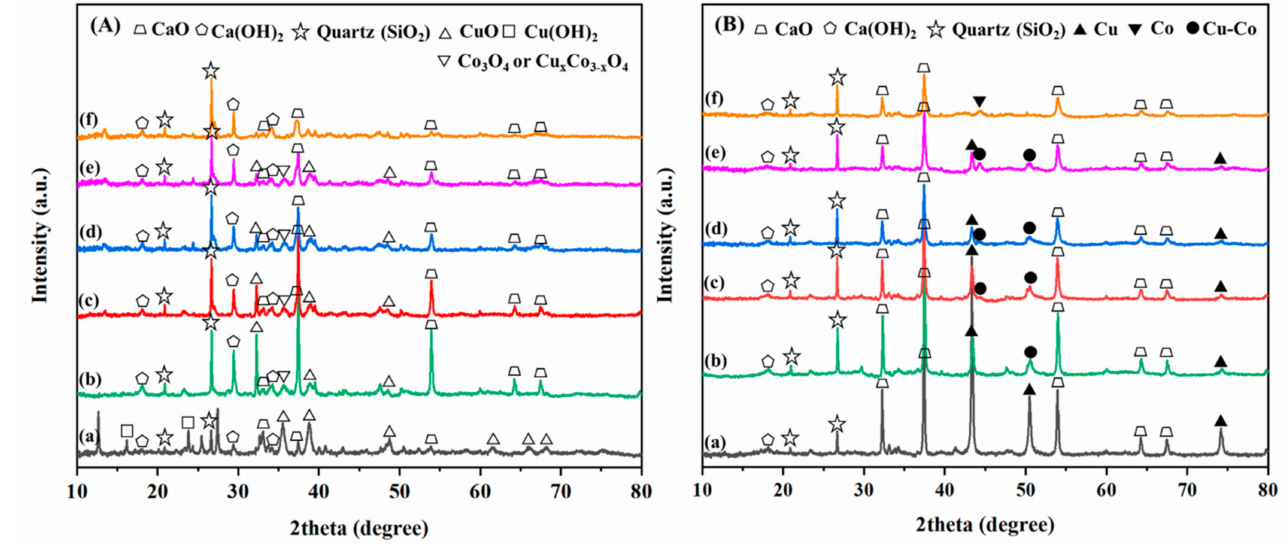
Figure 2. X-ray diffraction patterns of ( A ) calcined and ( B ) reduced (a) Cu/CaO, (b) Co 0.49 Cu 1 /CaO, (c) Co 0.96 Cu 1 /CaO, (d) Co 1.40 Cu 1 /CaO, (e) Co 1.94 Cu 1 /CaO, and (f) Co/CaO